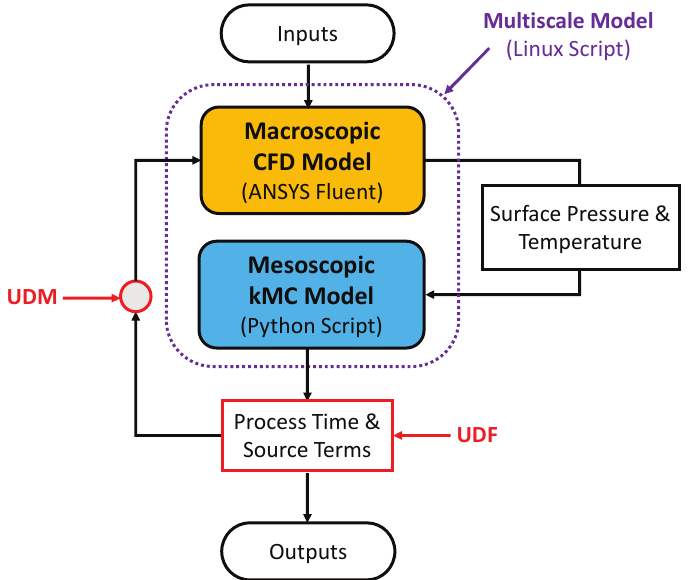
Figure 3. Coding architecture of the multiscale simulation using various programming languages to conjoin the mesoscopic and macroscopic simulations. In a Linux Shell script as an interface between the macroscopic and mesoscopic models, two models are simulated while exchanging pressure, temperature, and source generation (or consumption) with each